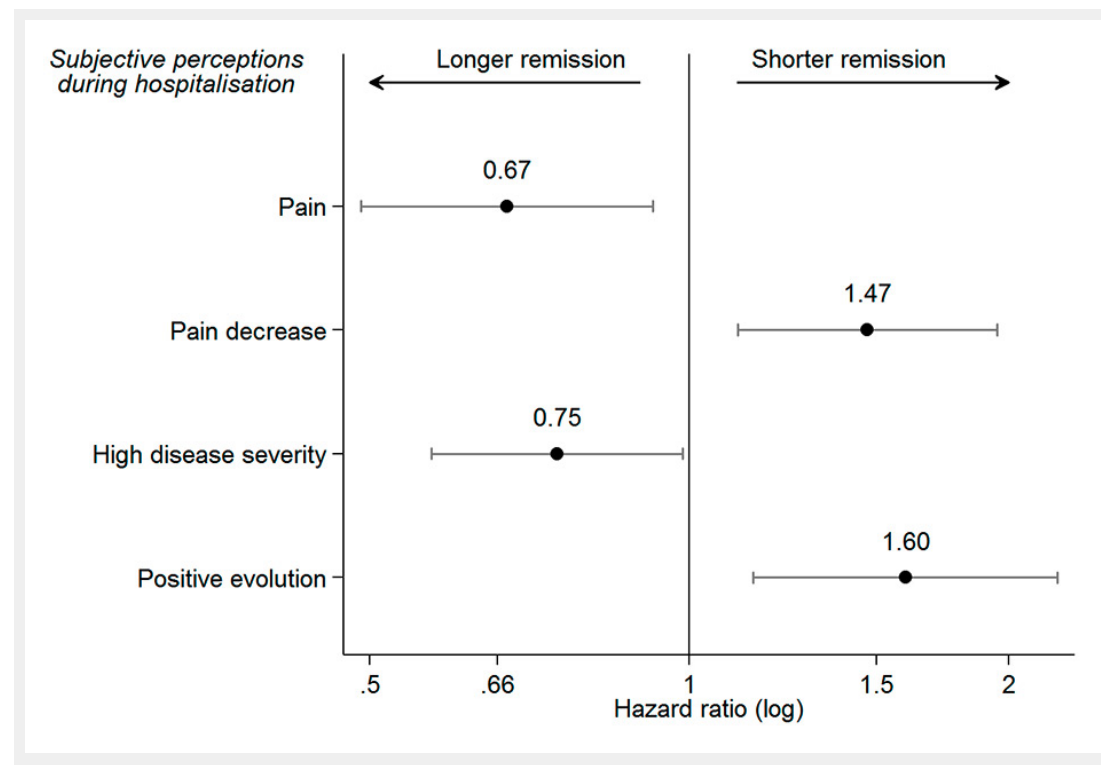
Supplementary Figure S1 Hazard ratios for the final model adjusted for Abbreviated Injury Scale score (n = 364). For pain and pain evolution, the hazard ratio refers to increments of two standard deviations. A hazard ratio above 1 shows an increased probability to be considered fit for